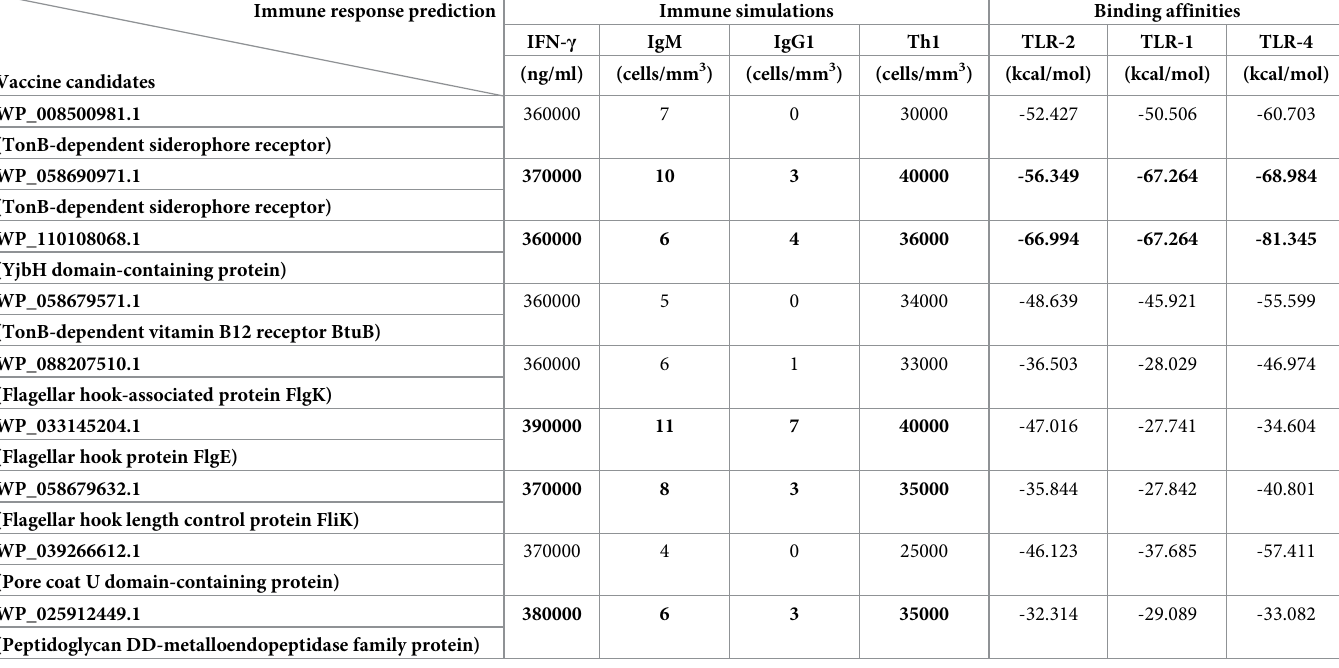
Table 1. Results of immune simulations and molecular dockings of nine putative vaccine candidates against clinical Enterobacter spp. Immune response